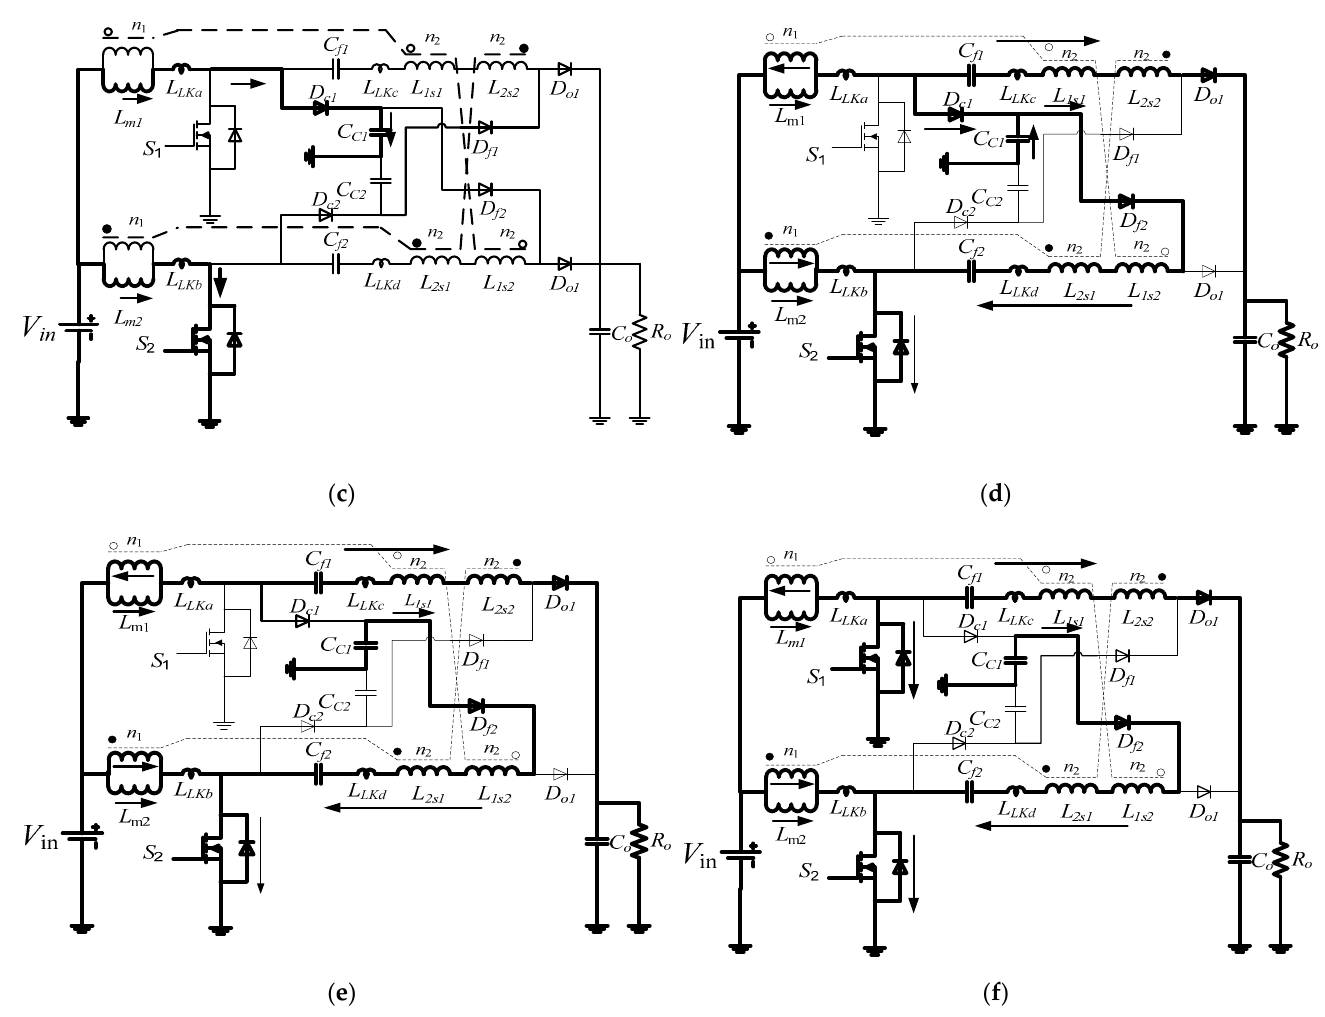
Figure 4. Operation stages of the interleaved high step-up current sharing converter. ( a ) Stage 1. ( b ) Stage 2. ( c ) Stage 3. ( d ) Stage 4. ( e ) Stage 5. ( f ) Stage 6.